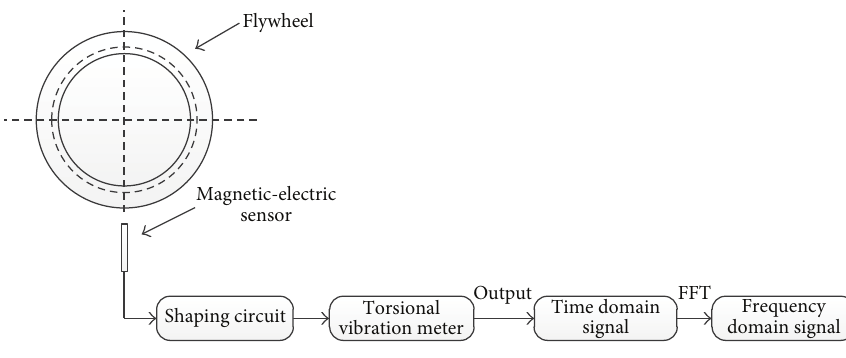
Figure 3: Typical torsional vibration test system.